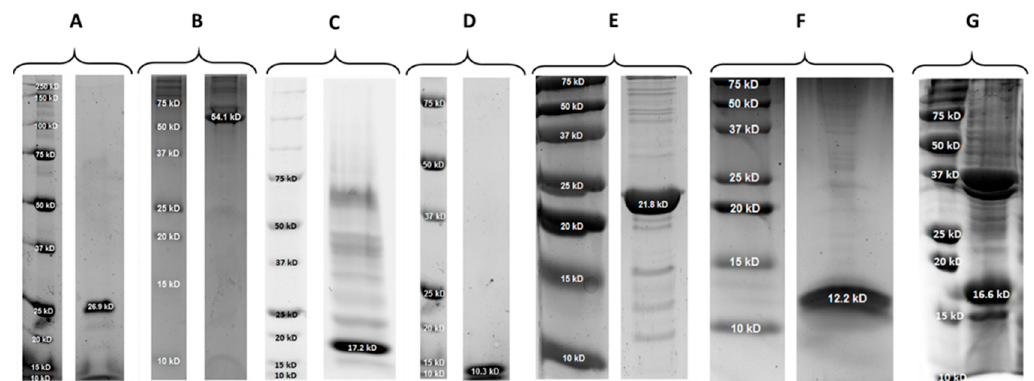
Figure A1. Confirmation by SDS-PAGE of the sizes (Left: protein ladder) and purity (Right: purified protein, the reported numbers represent the in silico calculated masses) of the constructs expressed and purified: PlySs2 ( A ), PlySs9 ( B ), PlySs2 CHAP ( C ), PlySs2 SH3_5 ( D ), PlySs9 amidase ( E ) and PlySs9 LysM ( F ). As PlySs9 endopeptidase ( G ) was present in the insoluble fraction, it was not purified. Gels consisted of 12.5% acrylamide and were stained with Coomassie brilliant blue.